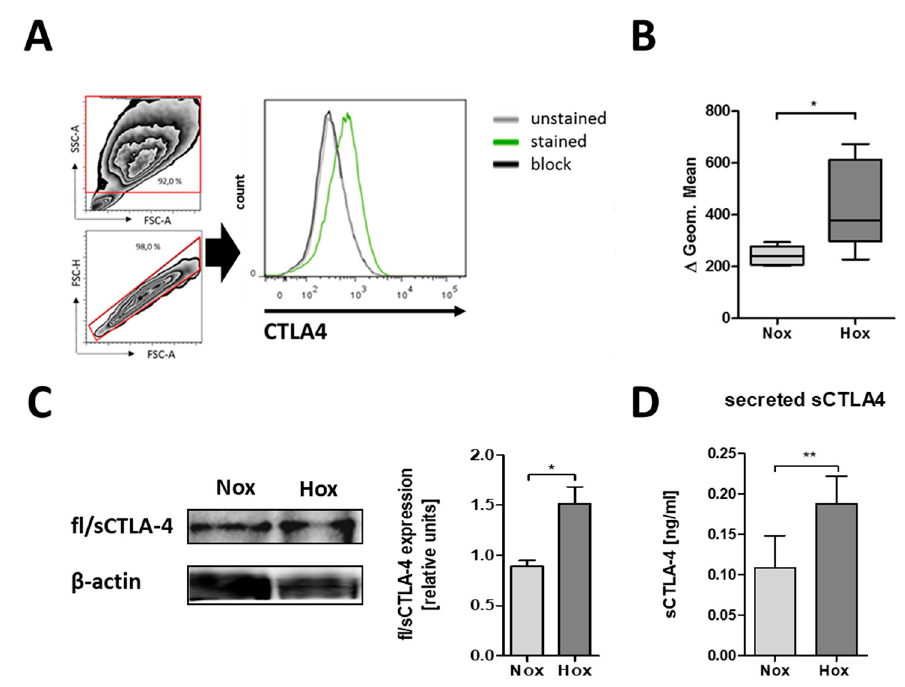
Figure 2. MSCs differentially express CTLA-4 protein with regard to oxygen availability. ( A ) Representative histogram of CTLA-4 surface expression on human bone marrow-derived MSCs and surface CTLA-4 staining of human MSCs as analyzed by flow cytometry. ( B ) Fluorescence intensities are depicted as box plots of delta of geometric means normalized to an antibody block ( n = 5; * p < 0.05; paired t -test). ( C , D ) Intracellular CTLA-4 expression and secretion by human MSCs was confirmed by immunoblotting after native PAGE and ELISA. ( C ) Intracellular fl/sCTLA-4 ( n = 4; * p < 0.05; paired t- test) and ( D ) secreted sCTLA-4 was enhanced in MSCs cultured under hypoxic conditions (Hox; 1% O 2 ) as compared to normoxic conditions (Nox; 18% O 2 ) ( n = 6; * p < 0.05; paired t -test).